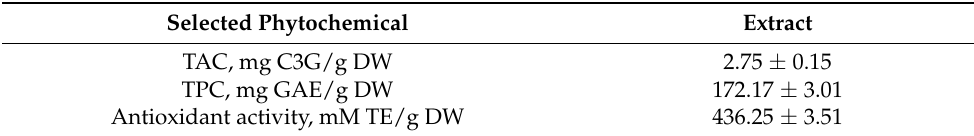
Table 1. The extract phytochemical